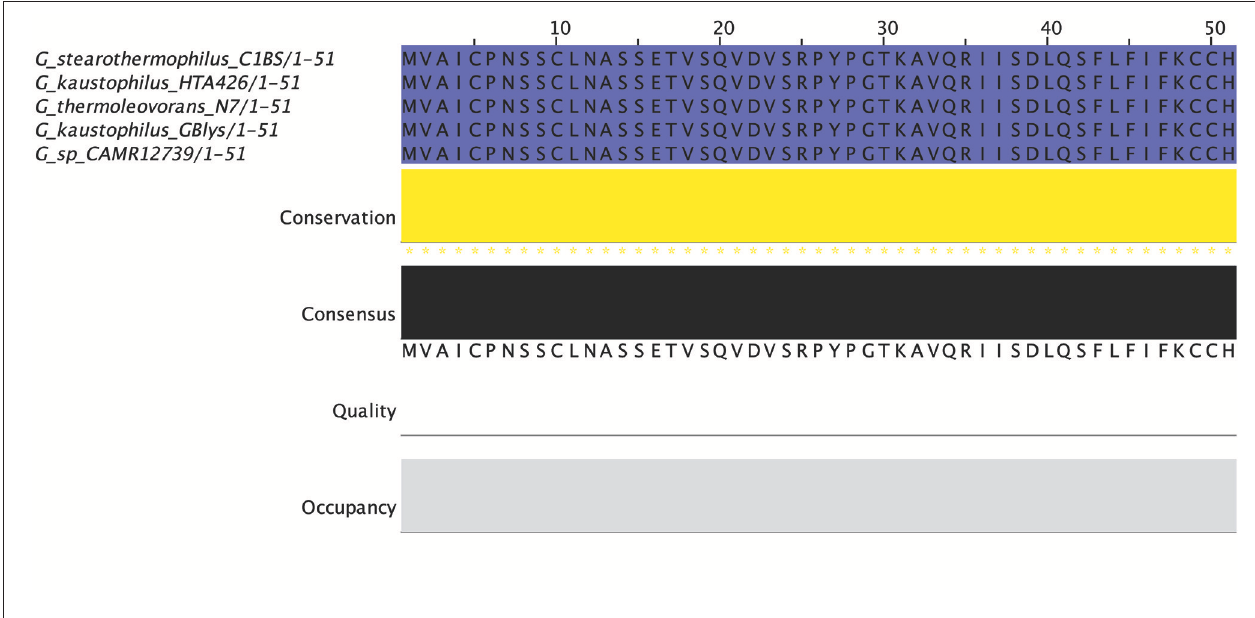
FIGURE 10 | Circular peptides (b) predicted by BAGEL.